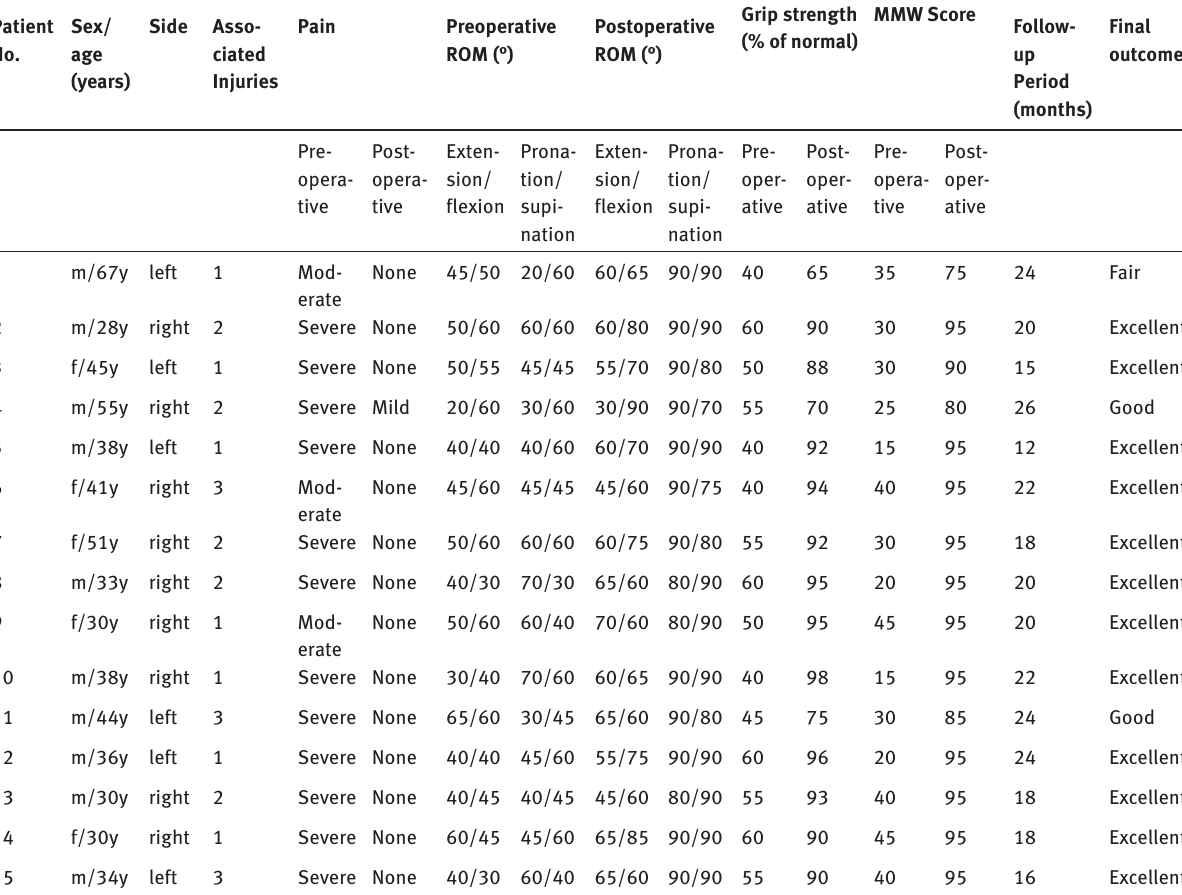
Table 3: The details of pre-operative evaluations and final follow-up outcomes in the fifteen patients.